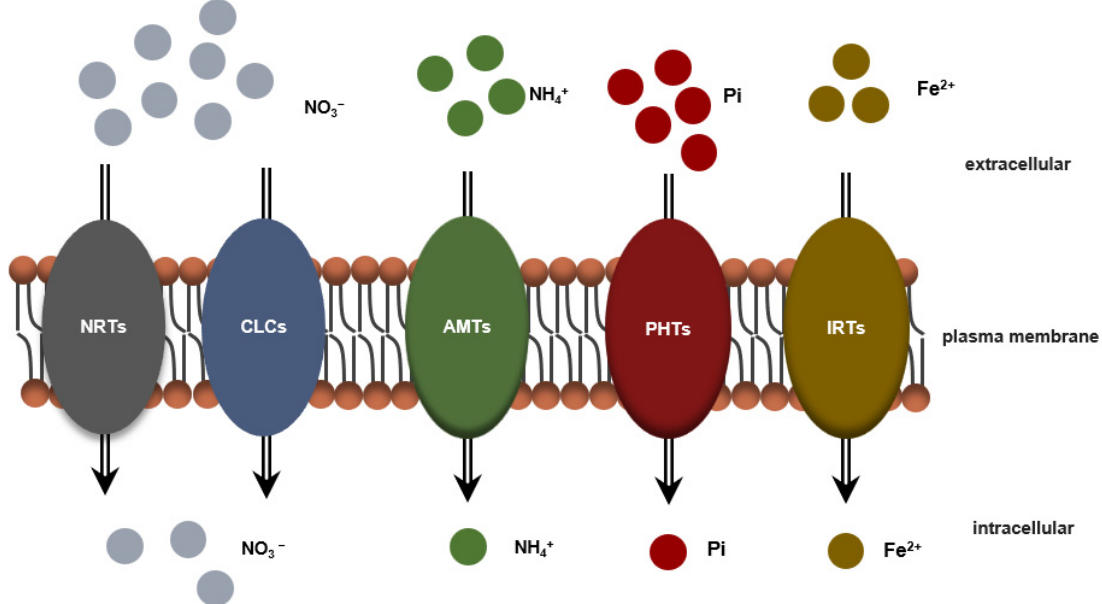
Figure 2. Working model for the direct target proteins regulating nutrient absorption in apple. Macro- and micronutrients such as NO 3 − , NH 4+ , Pi, and Fe 2+ are transported into plants through membrane transporters such as NRTs, AMT, CLCs, PHTs, and IRTs. NRTs: nitrate transporters; CLCs: chloride channel proteins; AMTs: ammonium transporters; PHTs: phosphate transporters; IRTs: iron-regulated transporters.